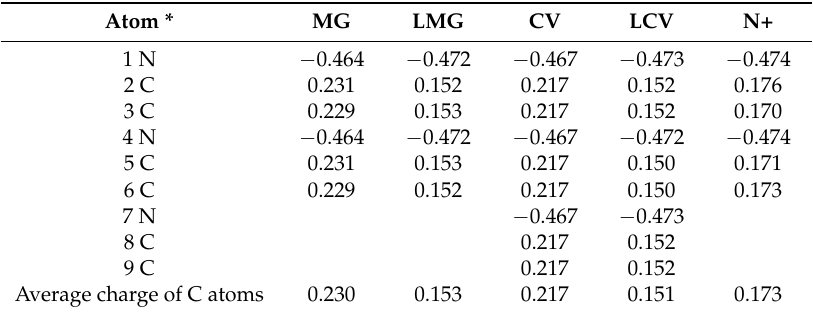
Table 2. Partial charges of the indicative atoms in MG, LMG, CV, LCV, and the designed hapten calculated at the B3LYP/6-31G* level.